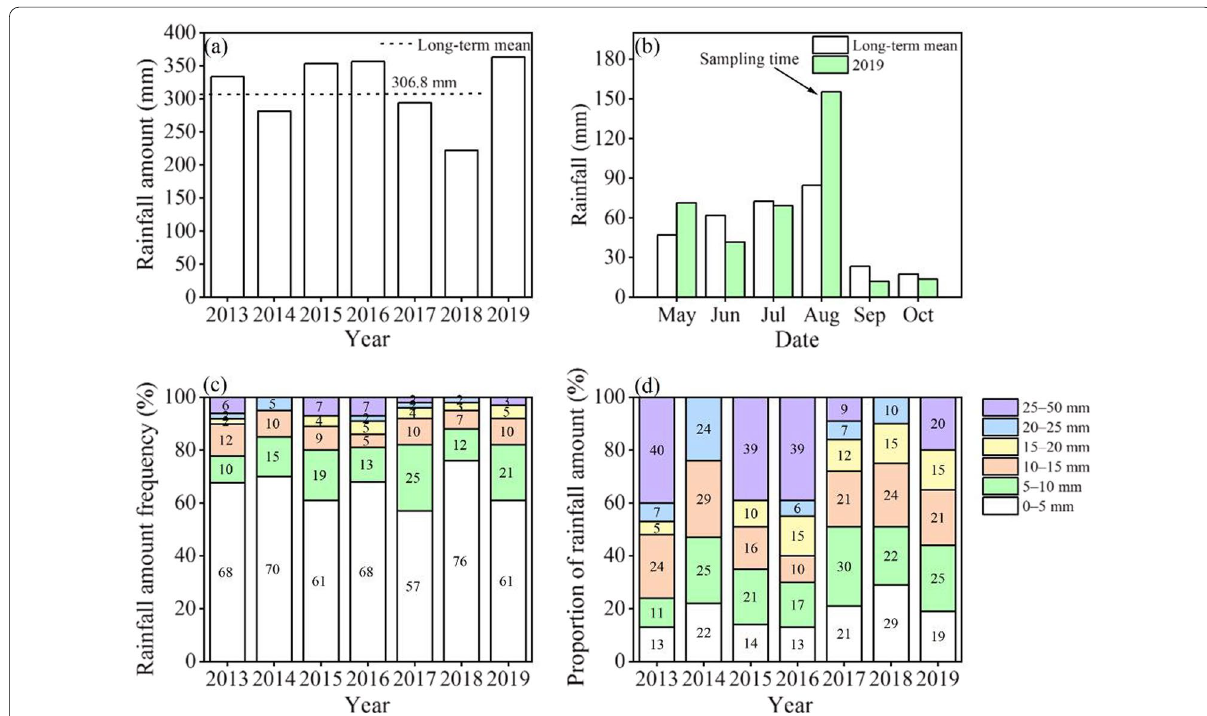
Fig. 2 Long‑term rainfall during the growing season ( a ); monthly rainfall amount in 2019 and long‑term mean (2013–2018) during the growing season ( b ); rainfall amount frequency ( c ); and the proportion of total rainfall amount ( d ) in